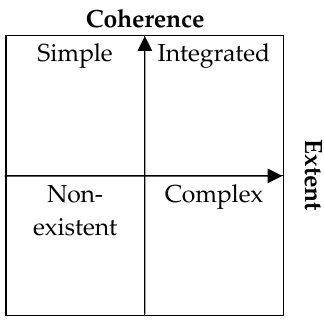
Figure 1. Di ff erent resource regime types according to their extent and coherence